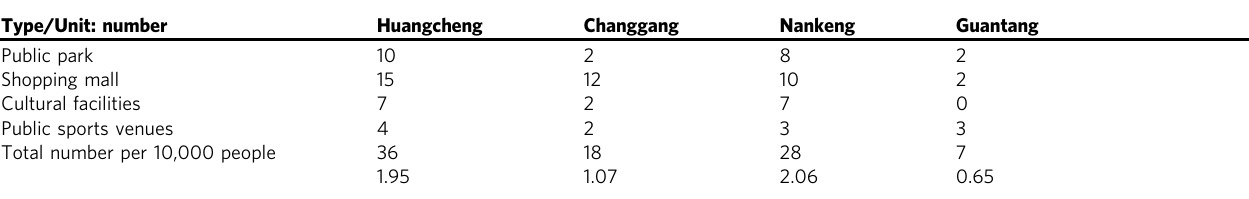
Table 2 Number of leisure facilities within 2 km around the case Communities. Type/Unit: number